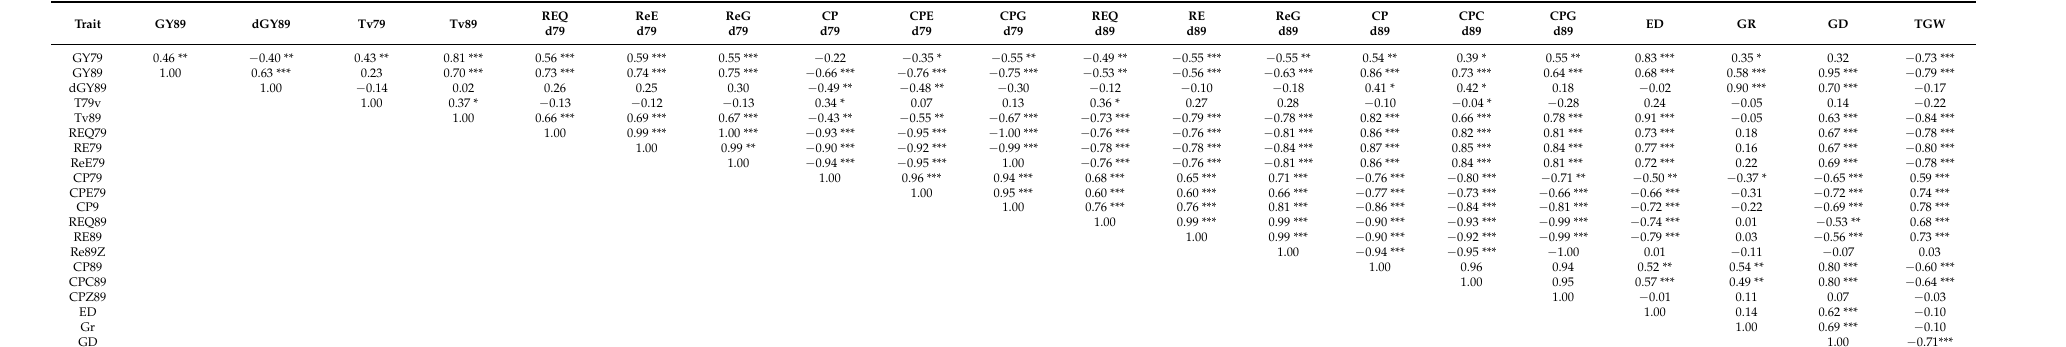
Table A3. Matrix of correlation indices for winter wheat remobilization indices during the period of grain formation and maturation, n =